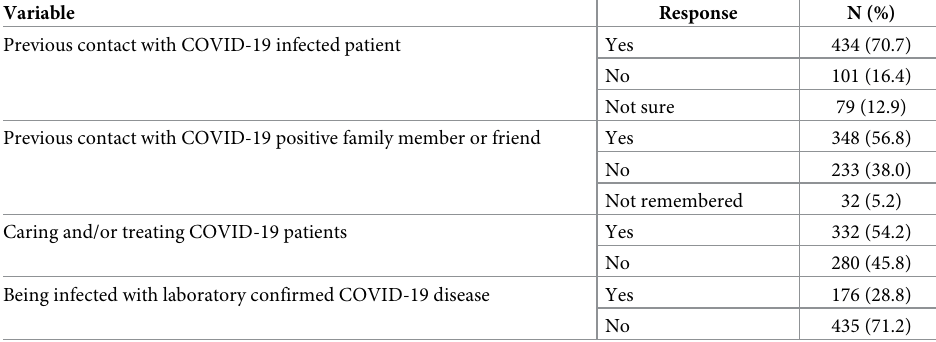
Table 2. Exposure status of healthcare providers to COVID-19